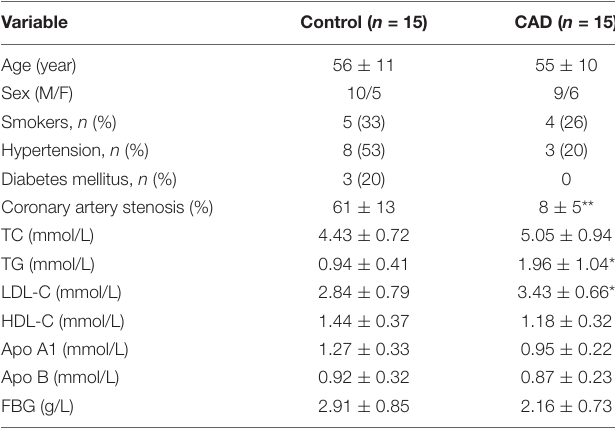
TABLE 1 | Demographic and clinical characteristics of the coronary artery disease (CAD) patients and the controls.